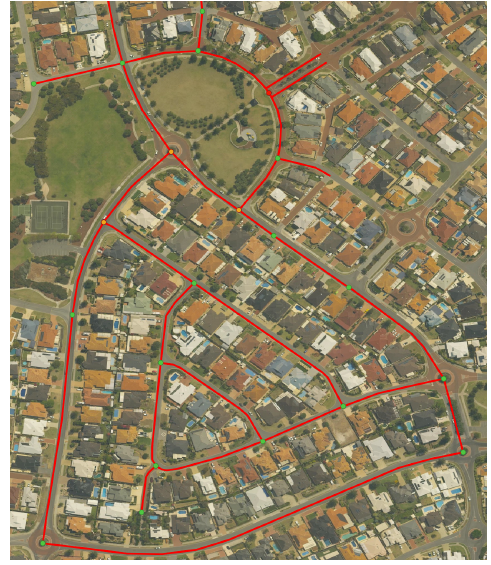
Figure 12. Property assertion view of an MRWA intersection after reasoning with Pellet in